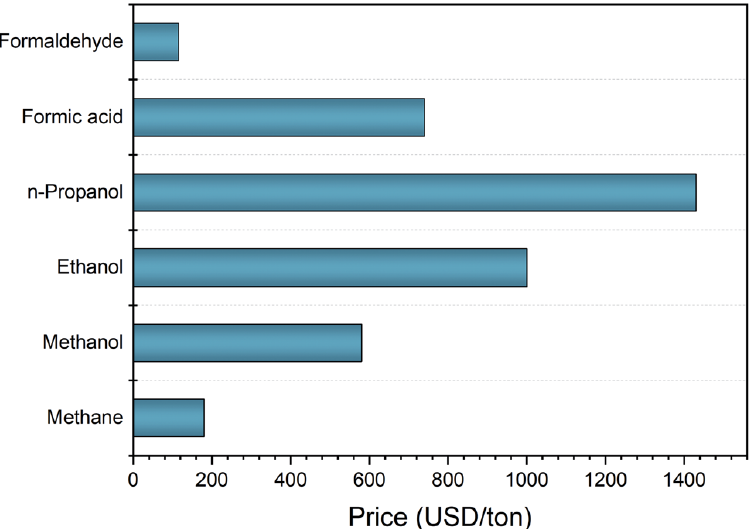
Figure 1. Price comparison of various oxygenated products produced from the methane oxidation reaction [6] . Copyright 2020, Royal Society of Chemistry.